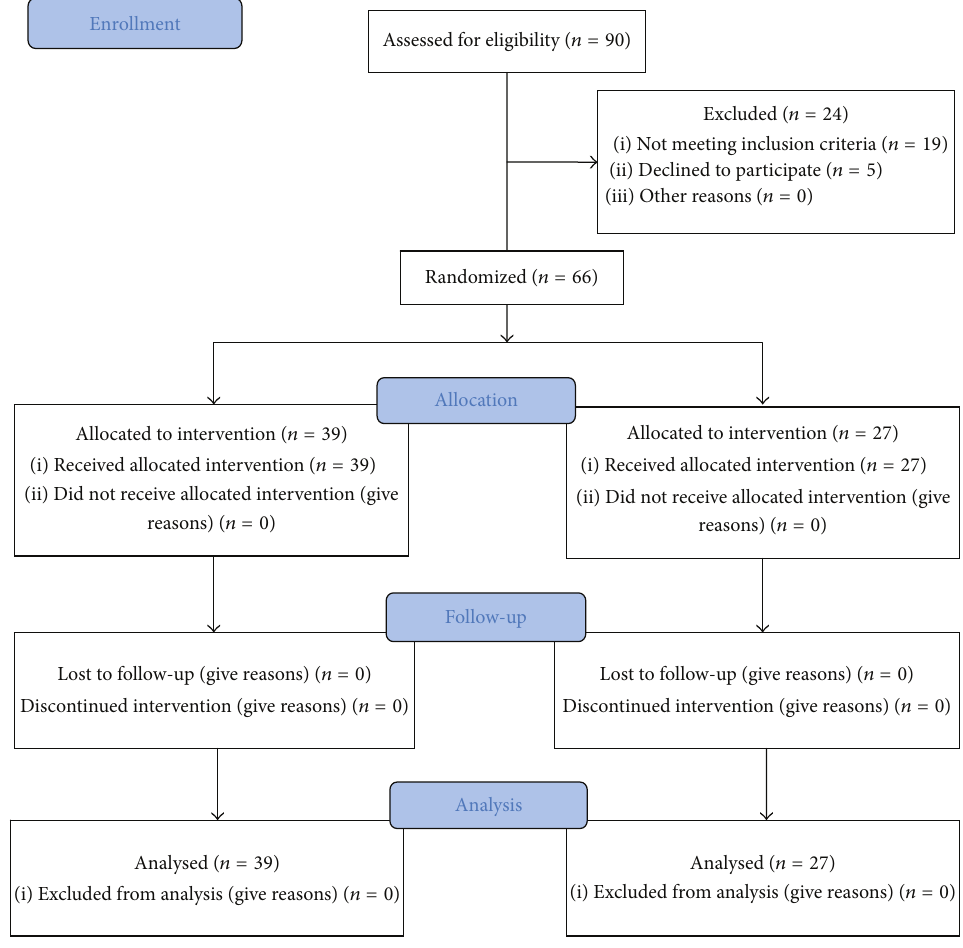
Figure 1: CONSORT 2010 flow diagram.